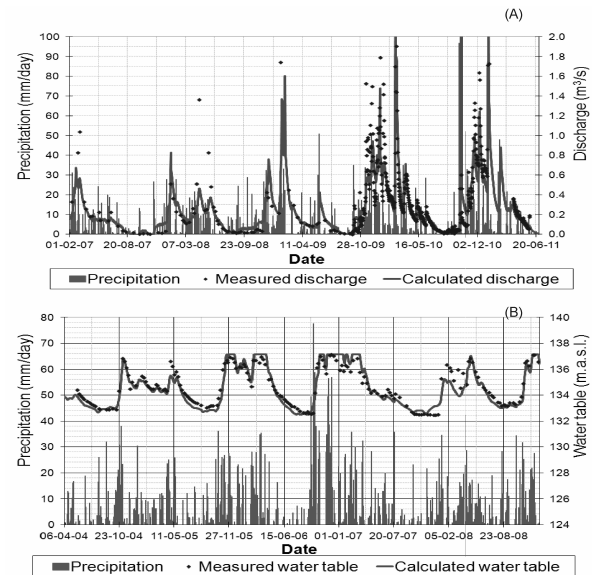
Fig. 4. Modeled versus measured flow rates in Abeleda Catchment (A) and modeled versus measured water table levels in Ferrol V Catchment (B)